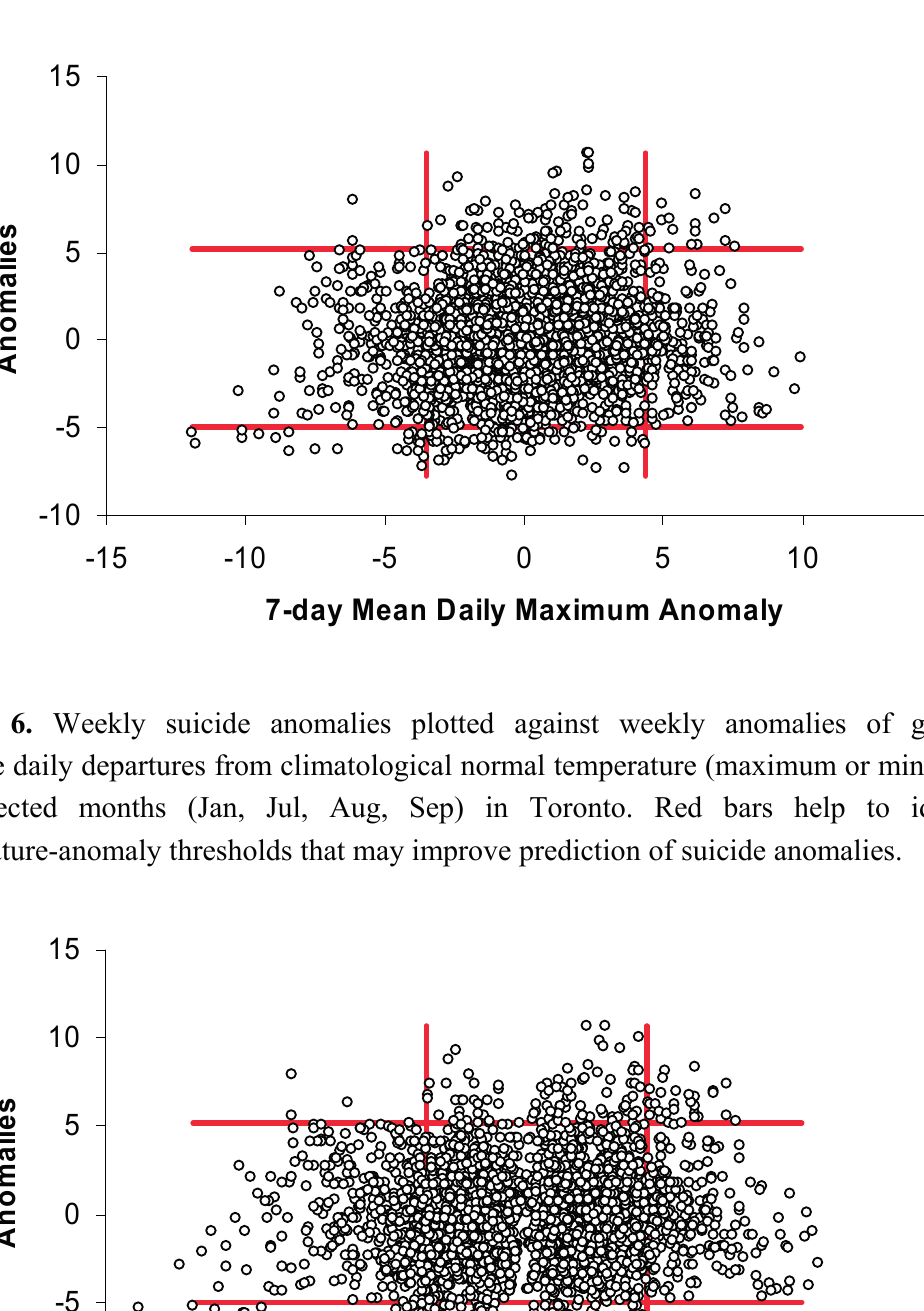
Figure 5. Weekly suicide anomalies plotted against weekly anomalies of daily maximum temperature for selected months (Jan, Jul, Aug, Sep) in Toronto. Red bars help to identify temperature-anomaly thresholds that may improve prediction of suicide anomalies.